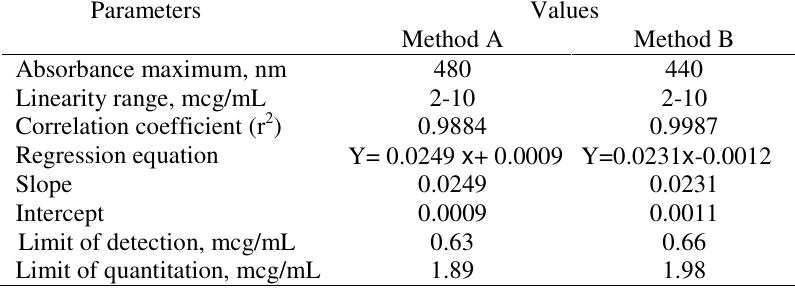
Table 1. Optical characteristics of the proposed methods.